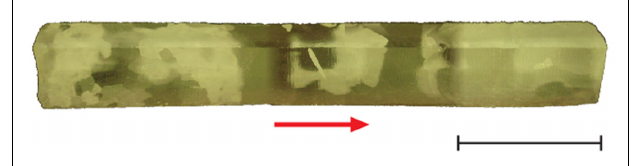
FIGURE 1 | Composite image of ice core section 3,519 viewed under cross-polarized illumination. The arrow is “up” and indicates the ice core orientation relative to the surface.The scale bar is